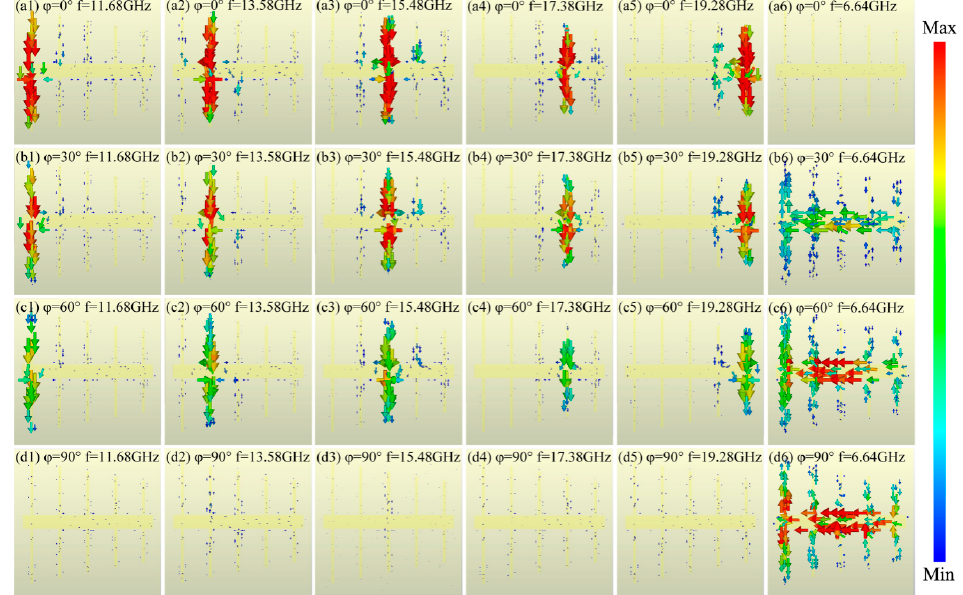
Figure 3. The surface current distributions at the absorption peaks under different polarization angles φ of ( a1 – a6 ) 0°, ( b1 – b6 ) 30°, ( c1 – c6 ) 60°, and ( d1 – d6 ) 90°.